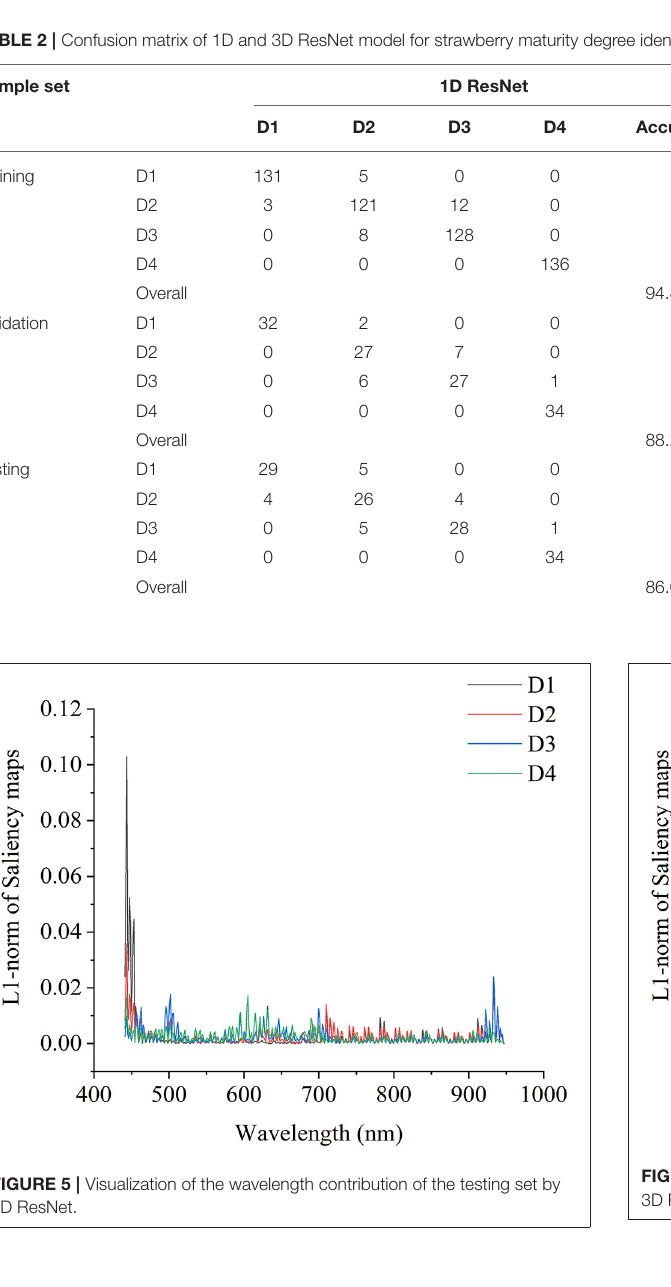
belong to two different maturity degrees, which would result in misclassification.